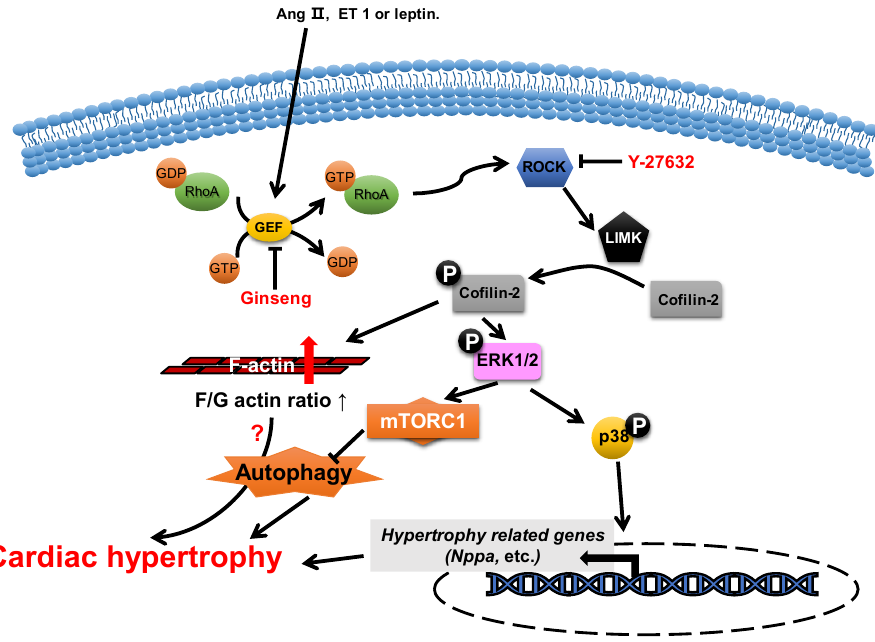
Figure 3. Proposed roles of cofilin-2 in cardiac hypertrophy. Neurohumoral factors (e.g., Ang II, ET 1 and leptin) lead to cofilin-2 phosphorylation through the RhoA/ROCK/LIMK signaling pathway. Phosphorylated cofilin-2 can lead to F-actin accumulation, which may subsequently contribute to cardiac hypertrophy through disrupting autophagy. In addition, it promotes the activation of ERK1/2 and p38, which contributes to the inhibition of autophagy and the reactivation of hypertrophy-related genes, which subsequently cause cardiac